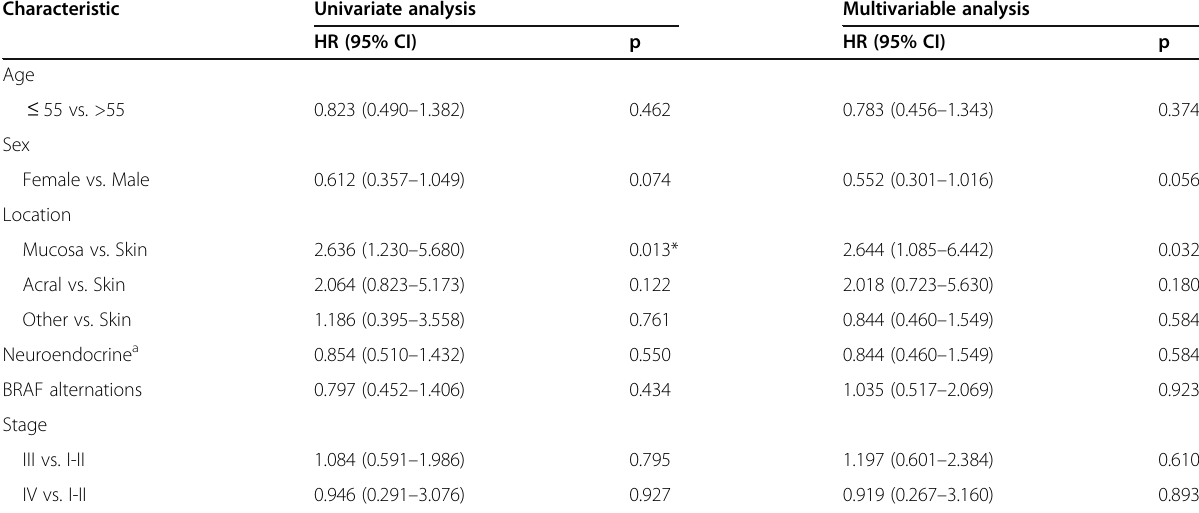
Table 5 Univariate and multivariable Cox proportional hazards model for PFS Characteristic Univariate analysis